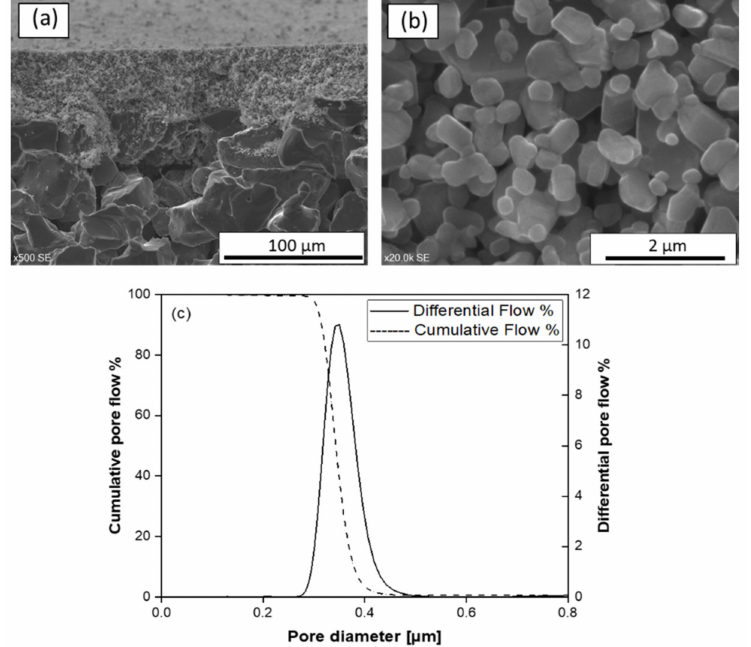
Figure 4. ( a , b ) SEM images of surface and cross-section of final SiC membrane sintered at T max -200 ◦ C, respectively and ( c ) Pore size distribution of final SiC